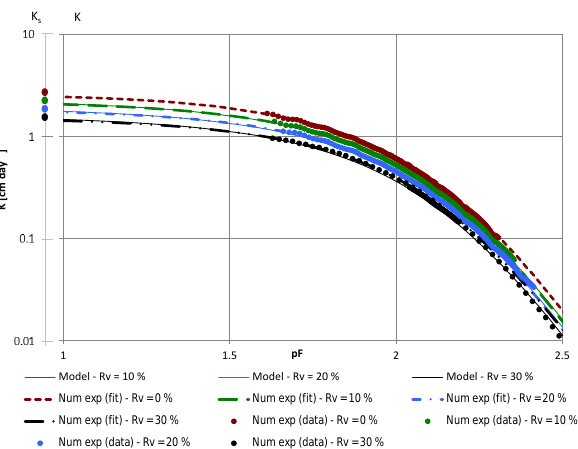
Figure 5. Hydraulic conductivity curves obtained from numerical experiments (data and fit for R v = 0, 10, 20, 30%) and results pre- dicted by the models for the corresponding R v .